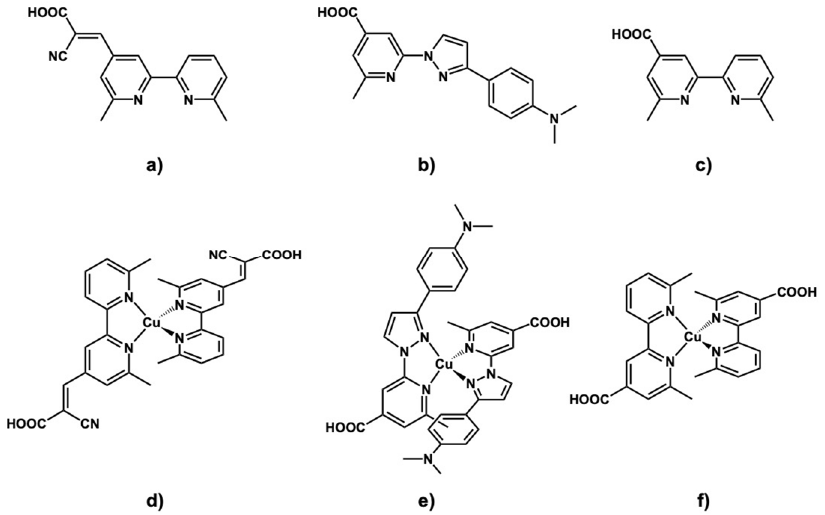
Figure 1. Schematic structures of ligands, ( a ) L1 , ( b ) L2 , and (c) L3 , and their Cu(I) complexes, ( d ) M1 , ( e ) M2 , and ( f ) Y3 .